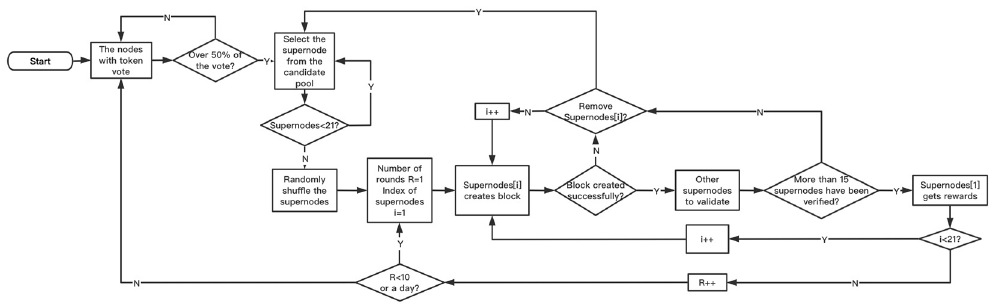
Figure 3. DPoS (Delegated Proof of Stake) algorithm flow.